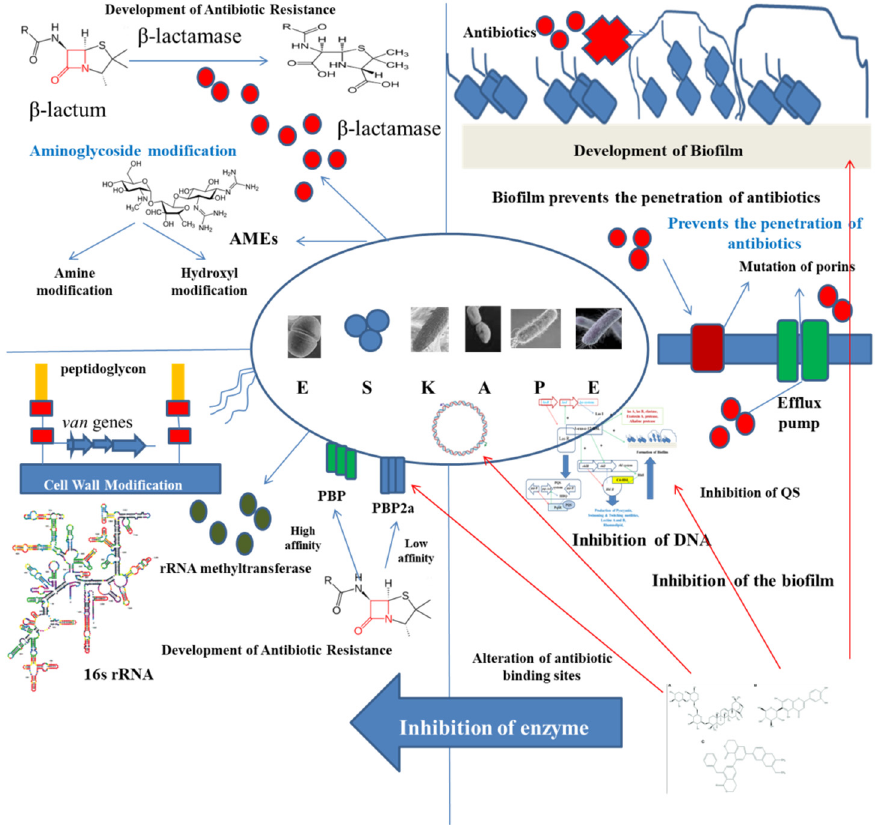
Figure 4. Mechanism of inhibition of QS and biofilm formation by ESKAPE pathogens with phyto- Figure 4. compounds.